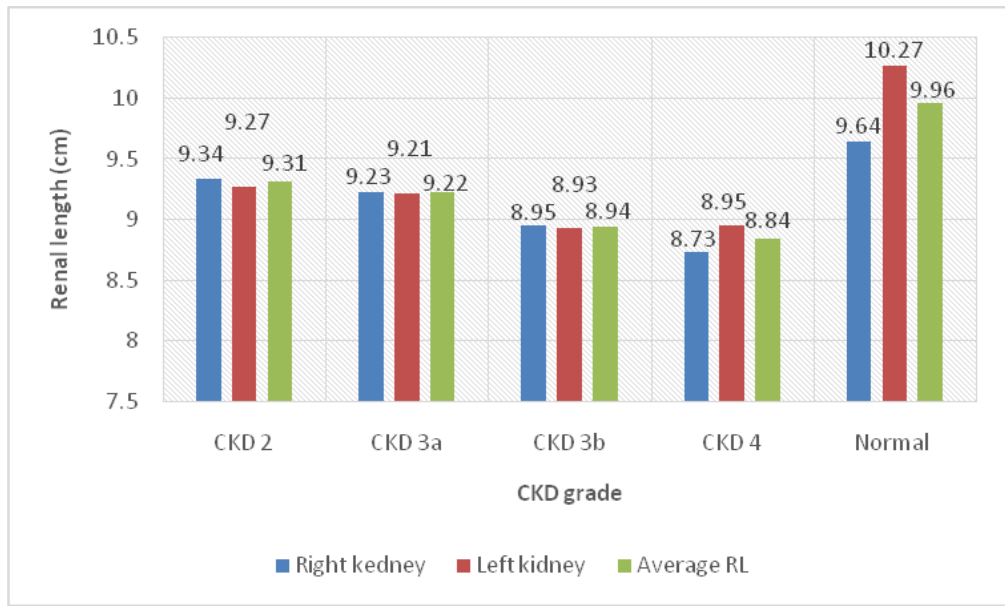
CKD - chronic kidney disease Figure 1: Renal lengths in health and in chronic kidney disease Table 02: Renal echogenicity grades in chronic kidney disease group and the control group